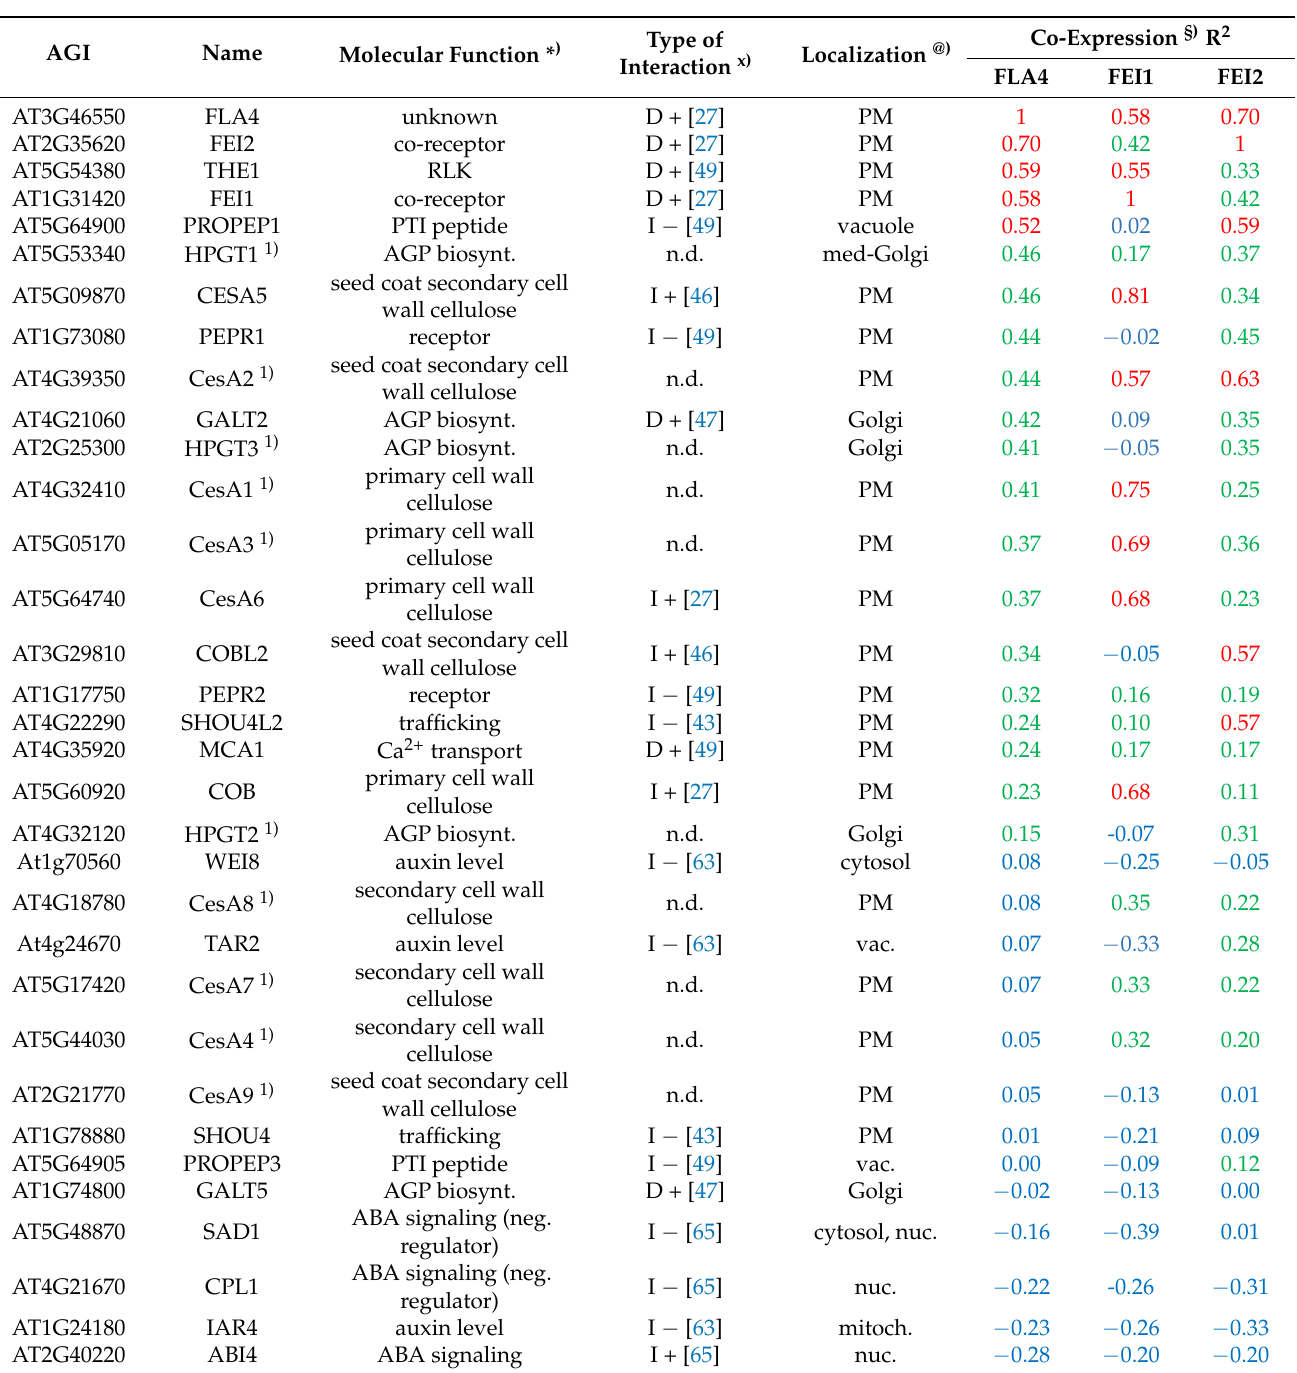
Table 1. Genetic interactors of the FLA4-FEI